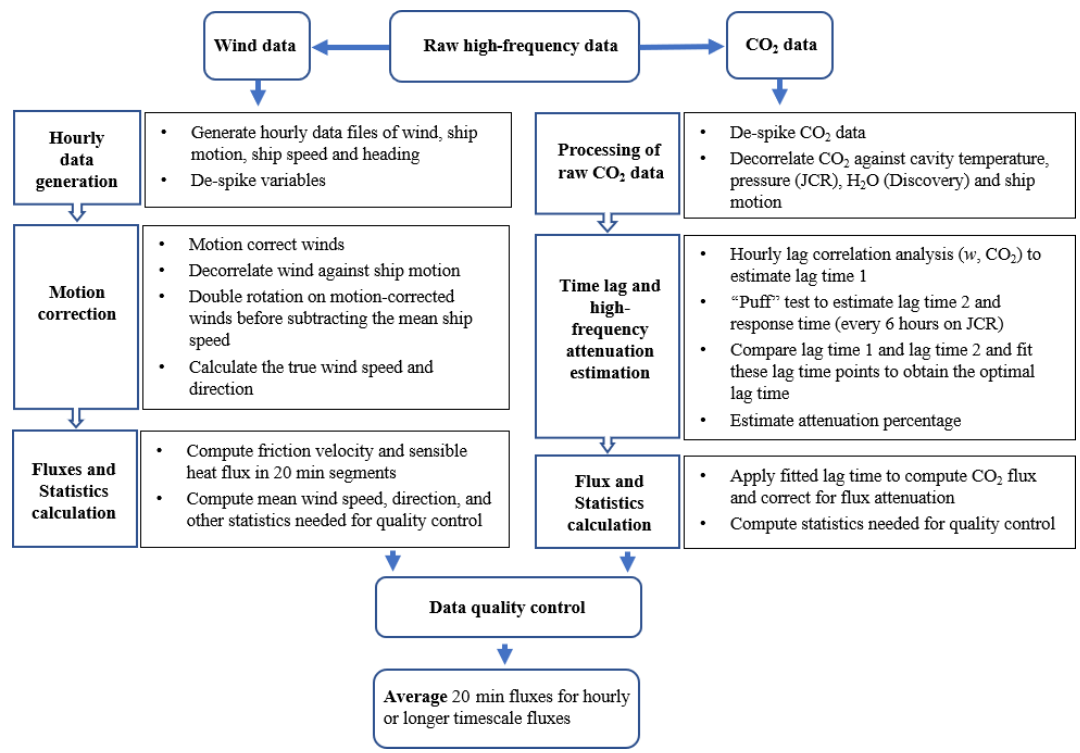
Figure 2. Flow chart of EC data processing. The raw high-frequency (10Hz) wind and CO 2 data were initially processed separately and then combined to calculate fluxes. CO 2 fluxes were filtered by a series of data quality control criteria. The 20min flux intervals were averaged to longer timescales (hourly or more). The data processing is detailed in the